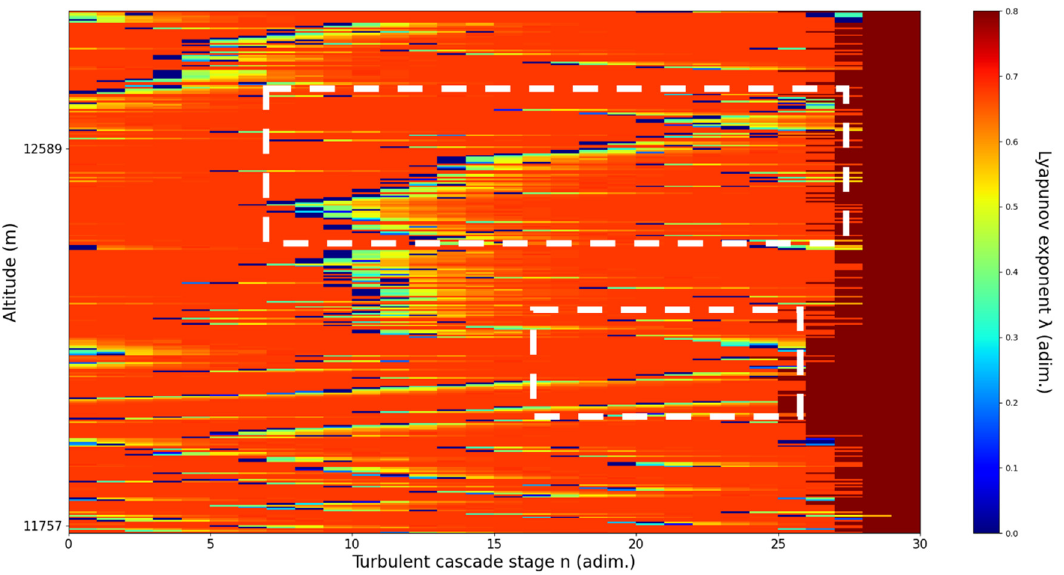
Figure 18. Lyapunov exponent per turbulent cascade stage colormap altitude plot, Bucharest, Romania, 13 June 2019,